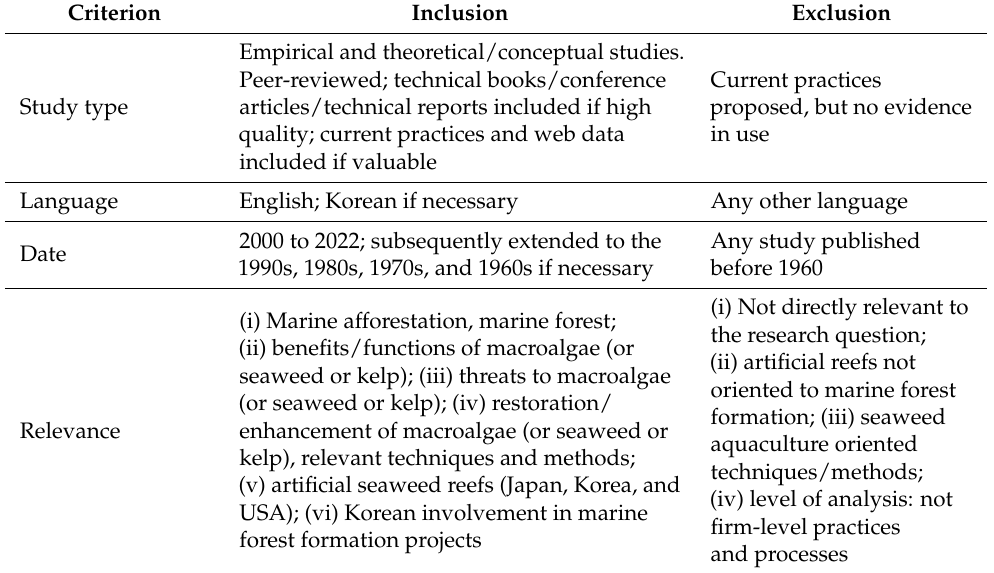
Table 2. Inclusion and exclusion